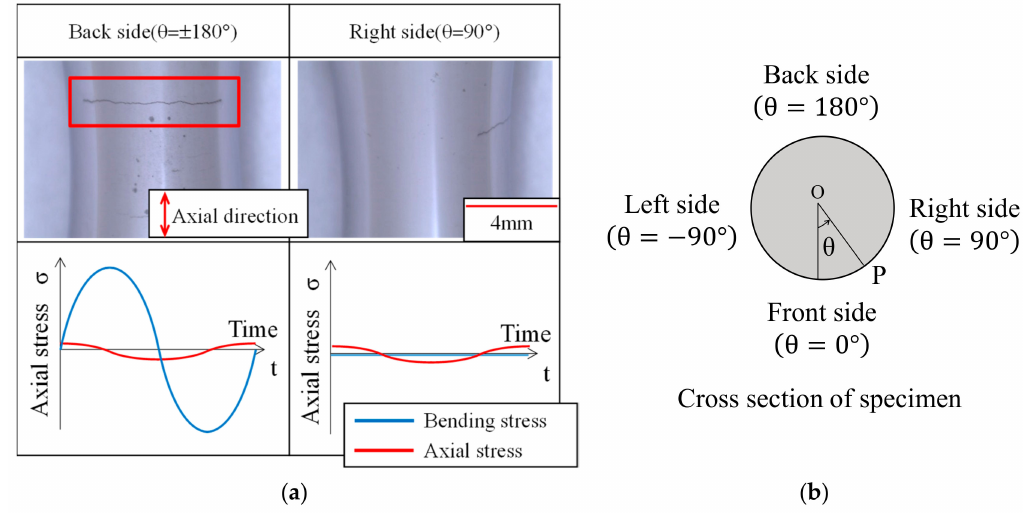
Figure 12. Observed results of the specimen surface following BT testing of the type 304